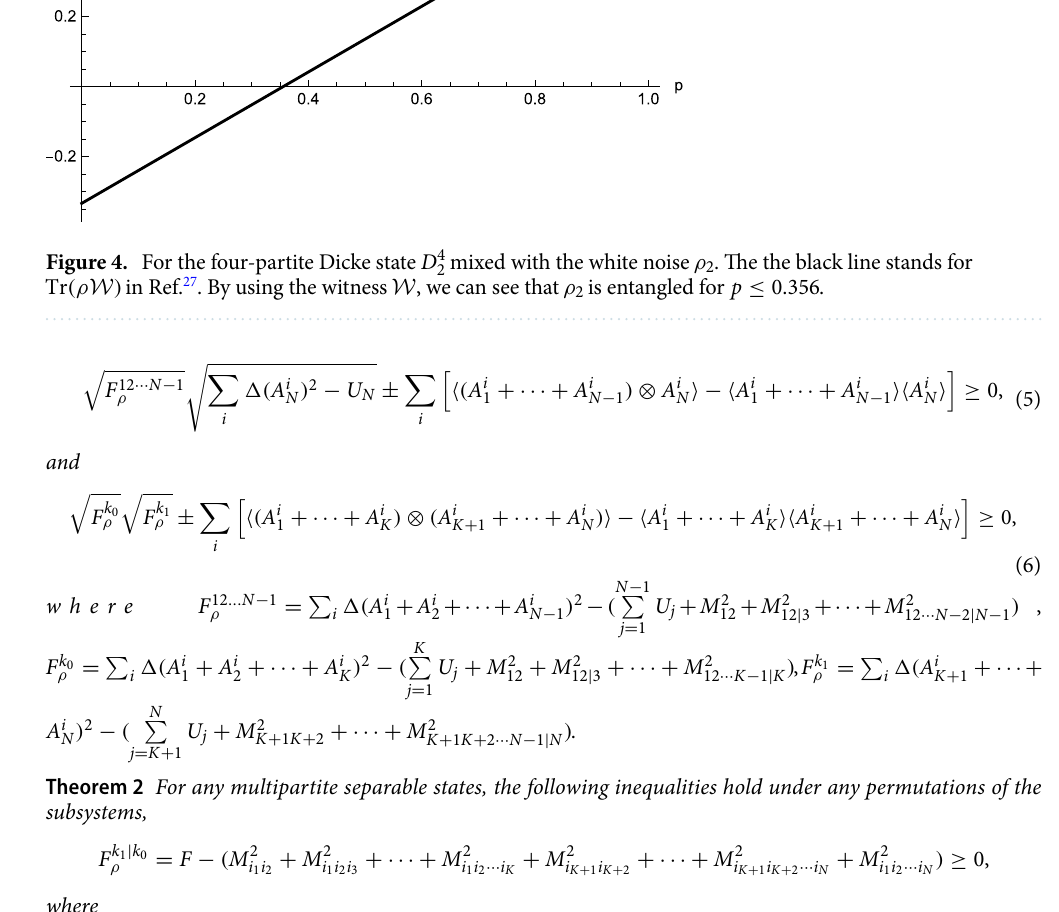
12 34 | ρ 2 in Theorem 1. When p